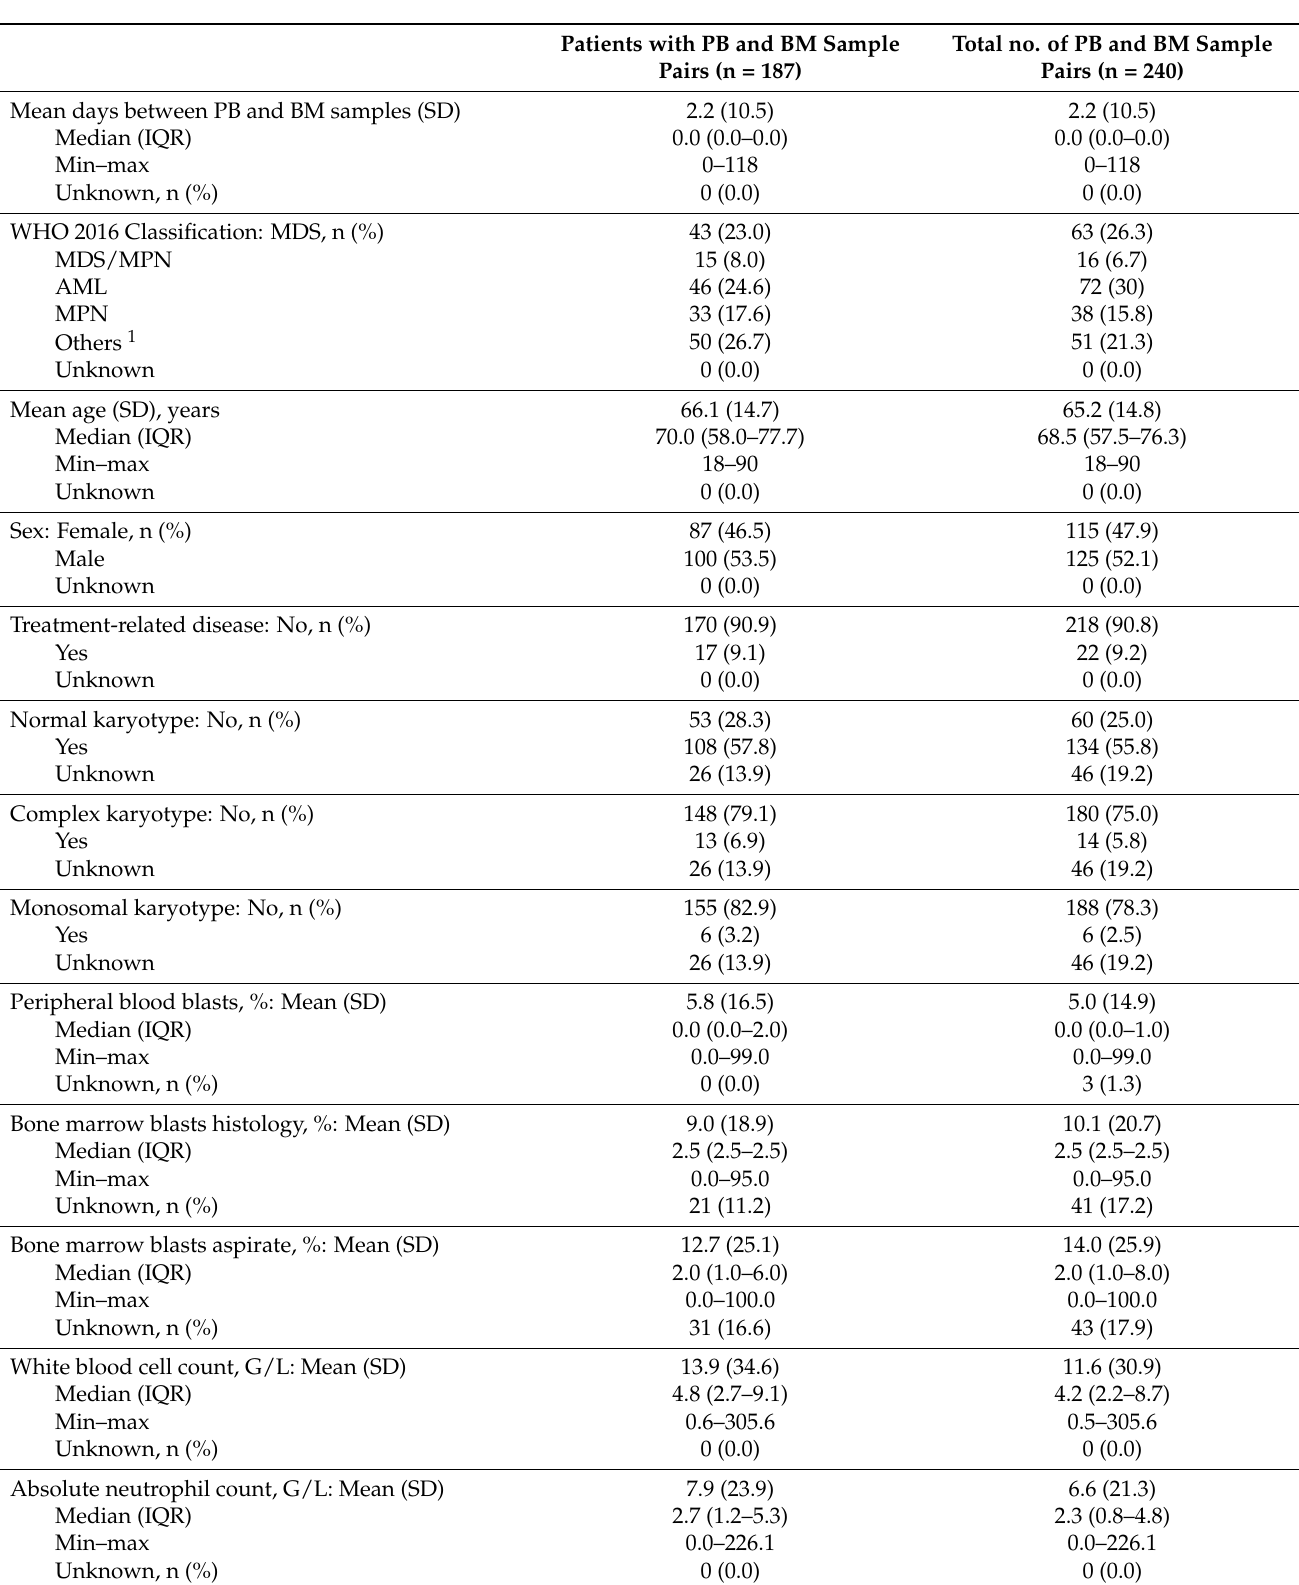
Table 2. Patient characteristics on the day of bone marrow assessment. Patients with PB and BM